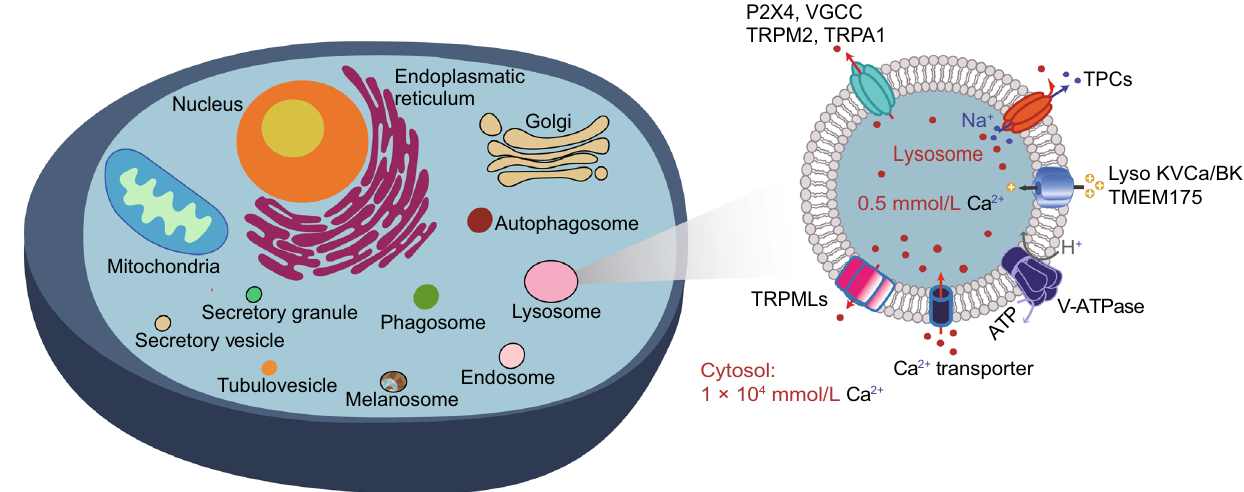
Figure 1. Intracellular Ca 2+ stores. Diagram of intracellular Ca 2+ stores, illustrating Ca 2+ release and uptake mechanisms. Large, continuous stores include the ER, the Golgi apparatus, mitochondria and the nucleus. Small, non-continuous vesicular stores, include endosomes, lysosomes, (auto)phagosomes and secretory vesicles, as well as vesicles in specialized cell types, such as tubulovesicles in parietal cells, melanosomes in melanocytes, synaptic vesicles in neurons and secretory granules in neurosecretory cells. TRPMLs, TPCs, P2X4, VGCCs, TRPA1 and TRPM2 are potential Ca 2+ release channels in lysosomes. The H + gradient in the lysosome is established and maintained by V-ATPases, and the Ca 2+ gradient in lysosomes is established and maintained by a putative Ca